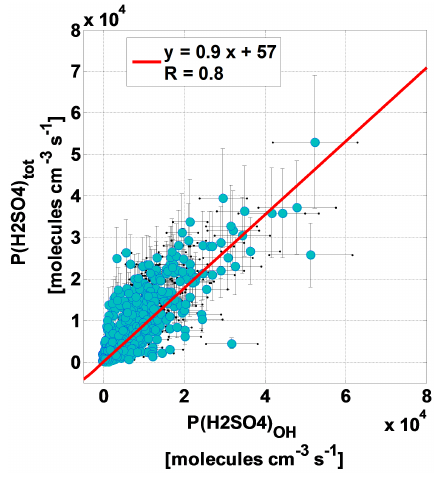
Figure 1. Total production rate of H 2 SO 4 (P(H 2 SO 4 ) tot ) as a func- tion of the production rate of H 2 SO 4 from the reaction between OH and SO 2 during the HOPE 2012 campaign. The linear regres- sion, following the method of York et al. (2004), yields a slope of 0.9 ± 0.02 and a intercept of 57 ±